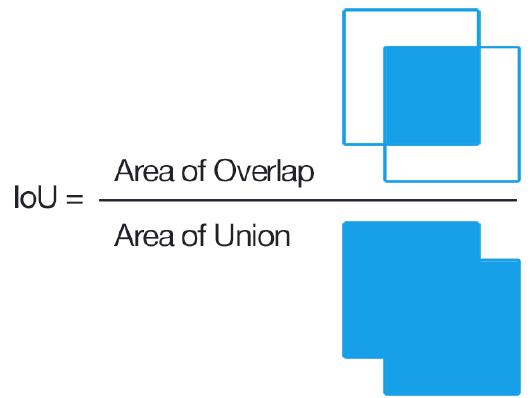
Figure 7. Illustration of IoU calculation. Source: Wikipedia.